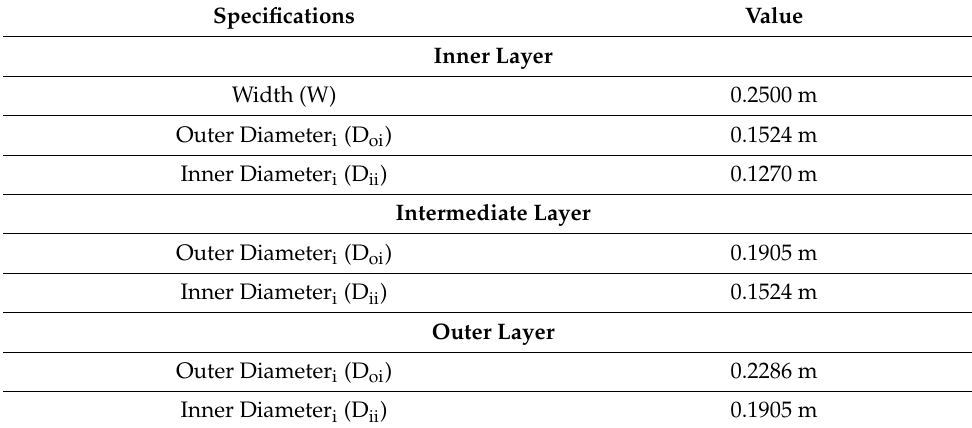
Table 3. Main geometrical parameters of the considered periodic inserts with sources of local resonance (three layers: Inner steel ring, VEM , outer steel ring).